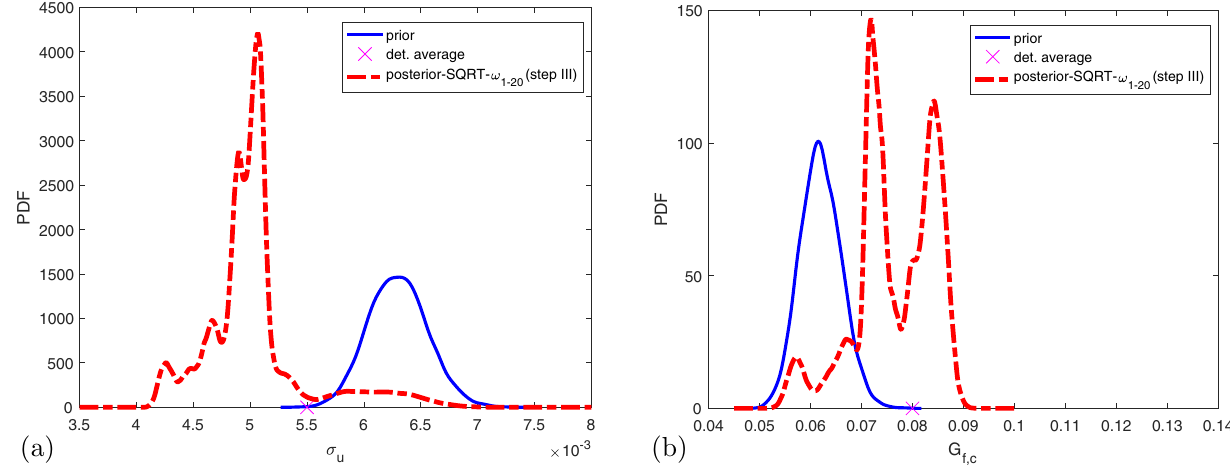
Fig. 18 Bayesian inference computation results for (non-Gaussian) PDF of model softening parameters obtained by (square root) GMKF: a Ultimate compressive strength 𝜎 u ; b Fracture energy in compression G f ,